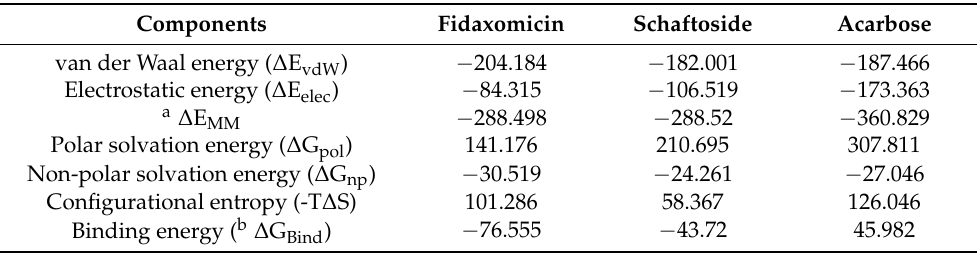
Table 1. Energetic components of the binding energy for three hits in complex with RBPJ using MM-PBSA (kJ/mol).